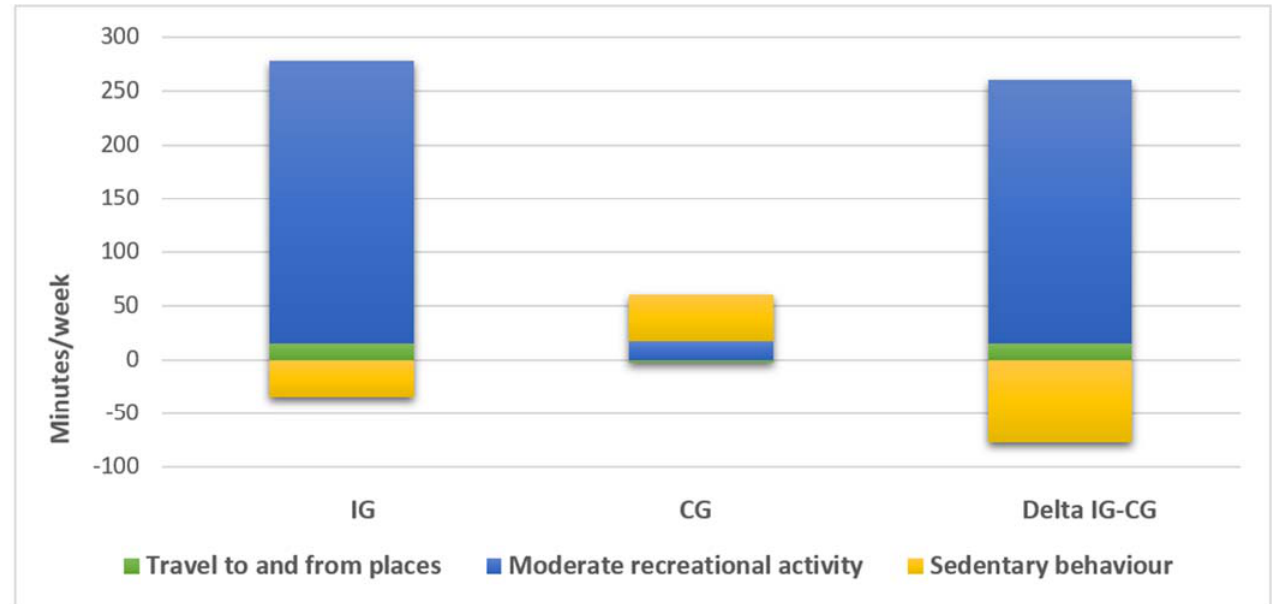
Figure 2. Patients’ modifications in physical activity after cardiac rehabilitation. Variations in physical activity levels evaluated with GPAQ in the intervention group (IG) and the control group (CG). The differences between the three-month follow-up and the baseline assessments are shown for both study groups. Furthermore, a comparison between the two groups is illustrated ( Δ IG-CG).